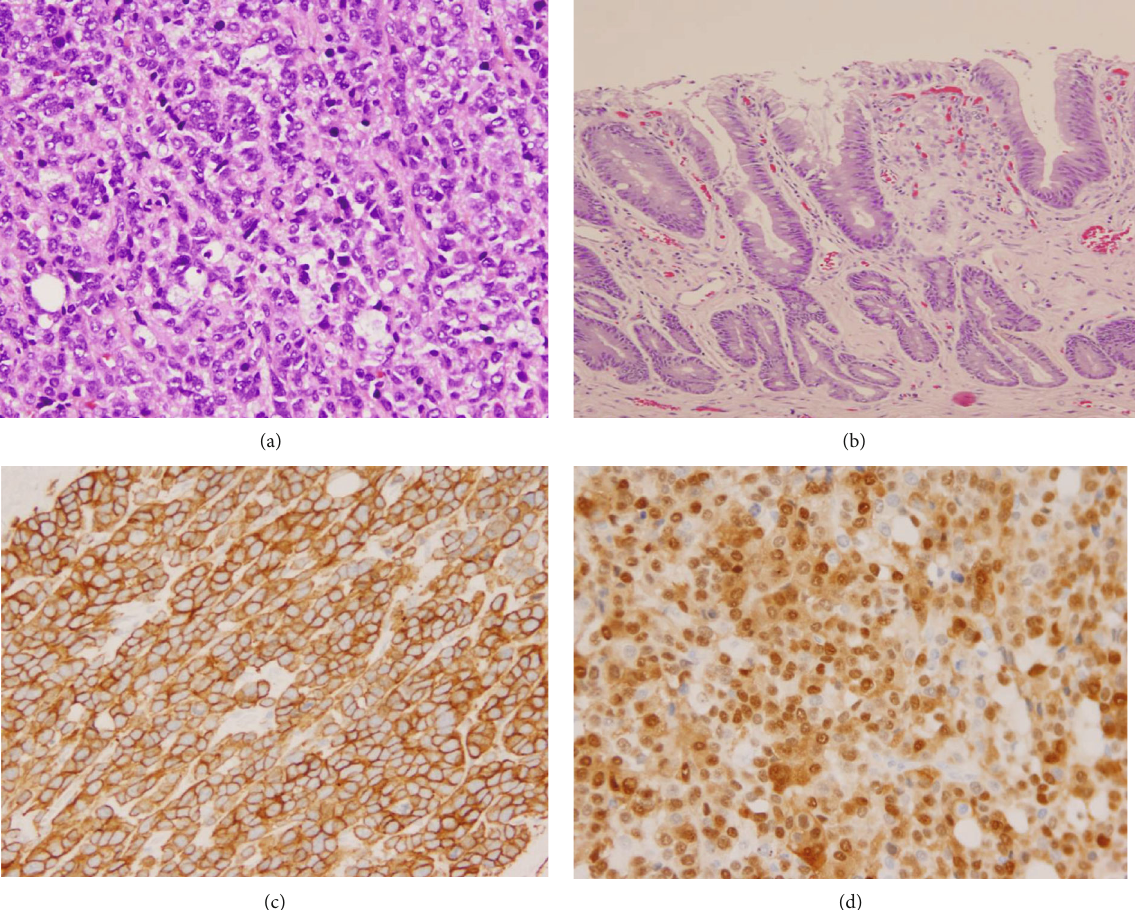
Figure 3: Esophageal adenocarcinoma arises from Barrett ’ s esophagus. (a) Poorly di ff erentiated invasive adenocarcinoma involving the submucosa of the esophagus (200x). (b) The adenocarcinoma originates from overlying Barrett ’ s esophagus with high-grade dysplasia (200x). (c) Immunostain for AE1/AE3 demonstrates strong cytoplasmic and membrane pattern positivity (200x). (d) Esophagus, immunostain for cyclin D1 demonstrates strong nuclear pattern positivity